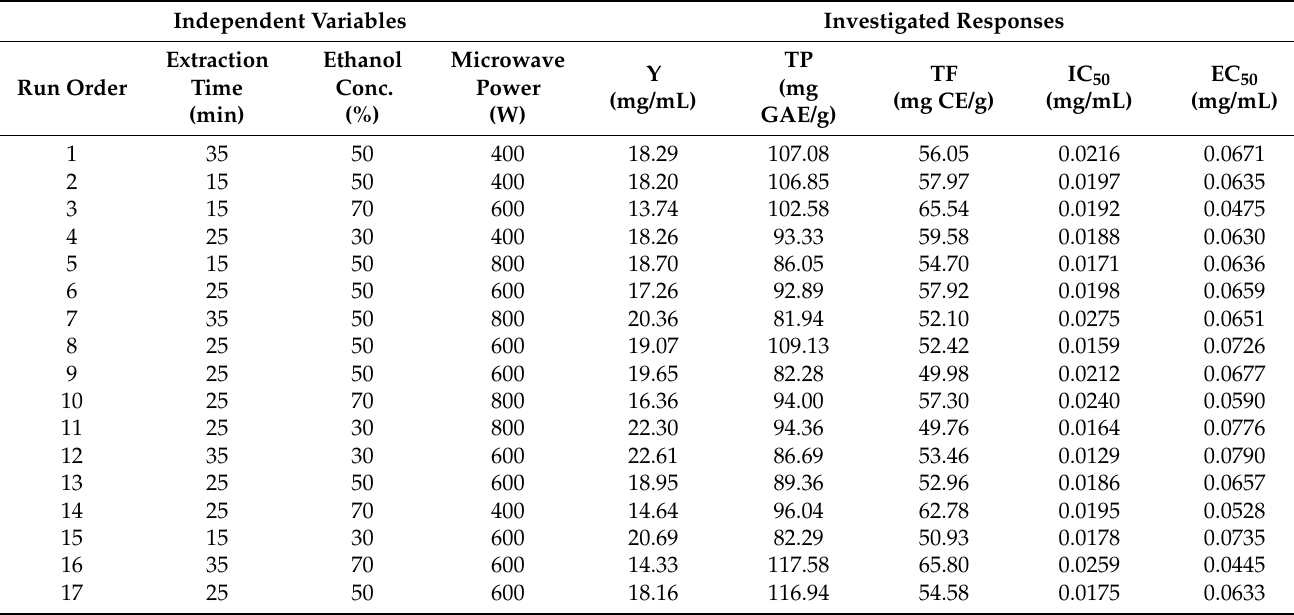
Table 2. BBD matrix with natural MAE parameters and experimentally observed values of TP, TF, IC 50 and EC 50